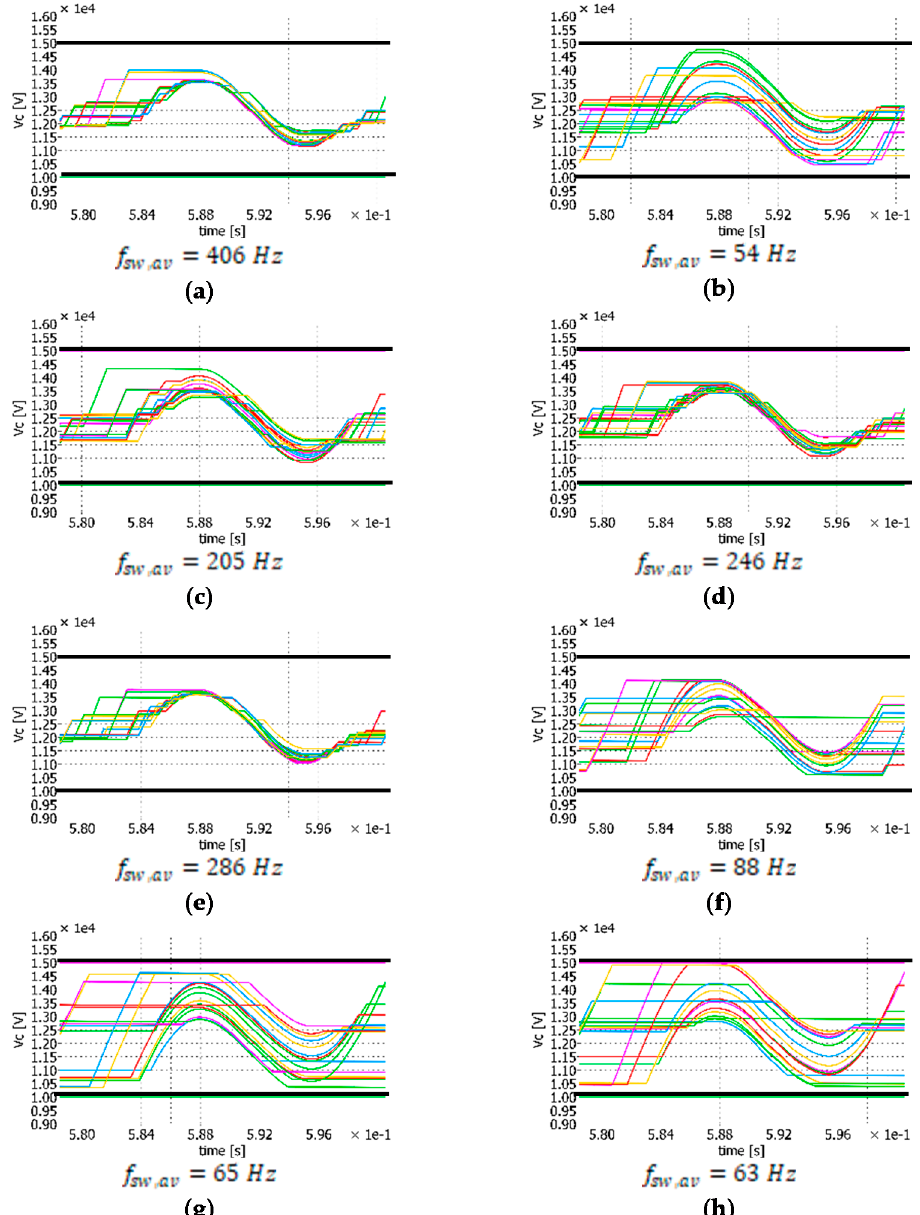
Figure 6. Achieved capacitor voltage waveforms during simulations applying different sorting methods: ( a ) Bubble Sorting Algorithm; ( b ) max/min approach; ( c ) Capacitor Voltage Mapping Strategy (CVMS) with M = 8 without switching frequency optimization (wosfo); ( d ) CVMS with M = 16 wosfo; ( e ) CVMS with M = 64 wosfo; ( f ) CVMS with M = 8 with switching frequency optimization (wsfo); ( g ) CVMS with M = 16 wsfo; ( h ) CVMS with M = 64 wsfo.